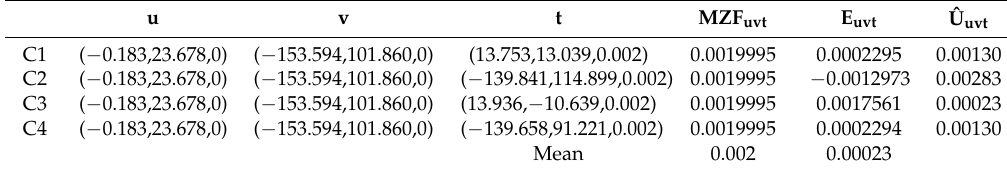
Table 2. Granite flatness measurement. CASE 3. Critical points (2,4–3,20), Data Table A1, Values in